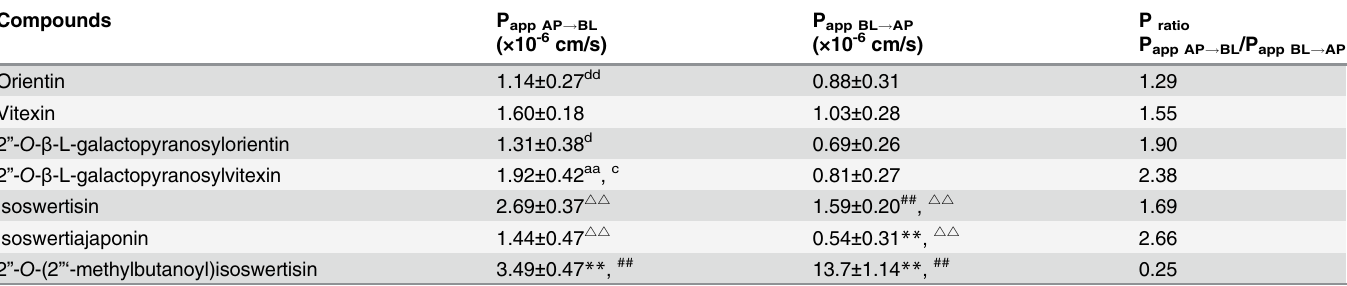
Table 3. The bidirectional P app values of the seven fl avonoids in the equimolar mixture.